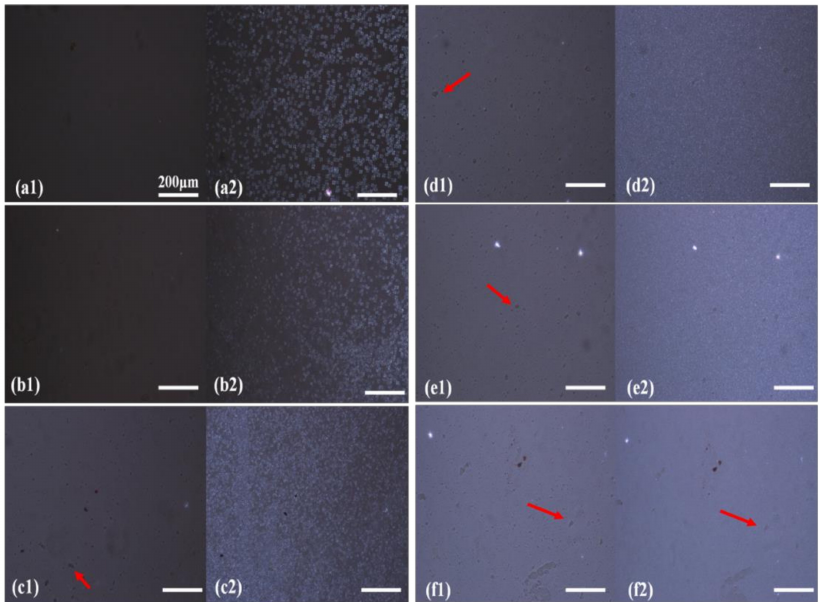
Figure 1. Polarizing optical microscopy (POM) images of olefin block copolymer/1,3;2,4- Bis(3,4-dimethylbenzylidene) sorbitol (OBC/DMDBS) samples at different temperatures: ( a1 ). OBC at 190 ◦ C; ( a2 ). OBC isothermally crystallized at 116 ◦ C for 10 min; ( b1 – f1 ). OBC/DMDBS samples with different content of DMDBS at 190 ◦ C; ( b2 – f2 ). OBC/DMDBS samples with different content of DMDBS isothermally crystallized at 116 ◦ C for 10